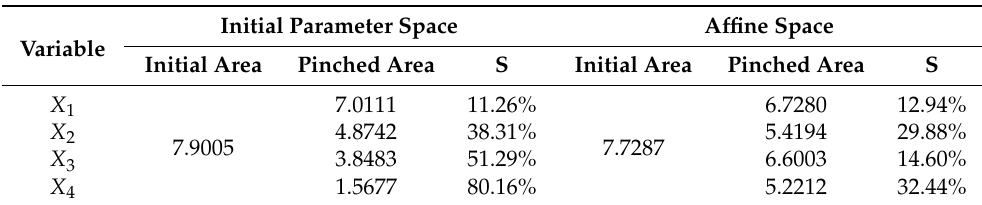
Table 2. The ranking order of the epistemic model parameters based on their respective sensitiv- ity